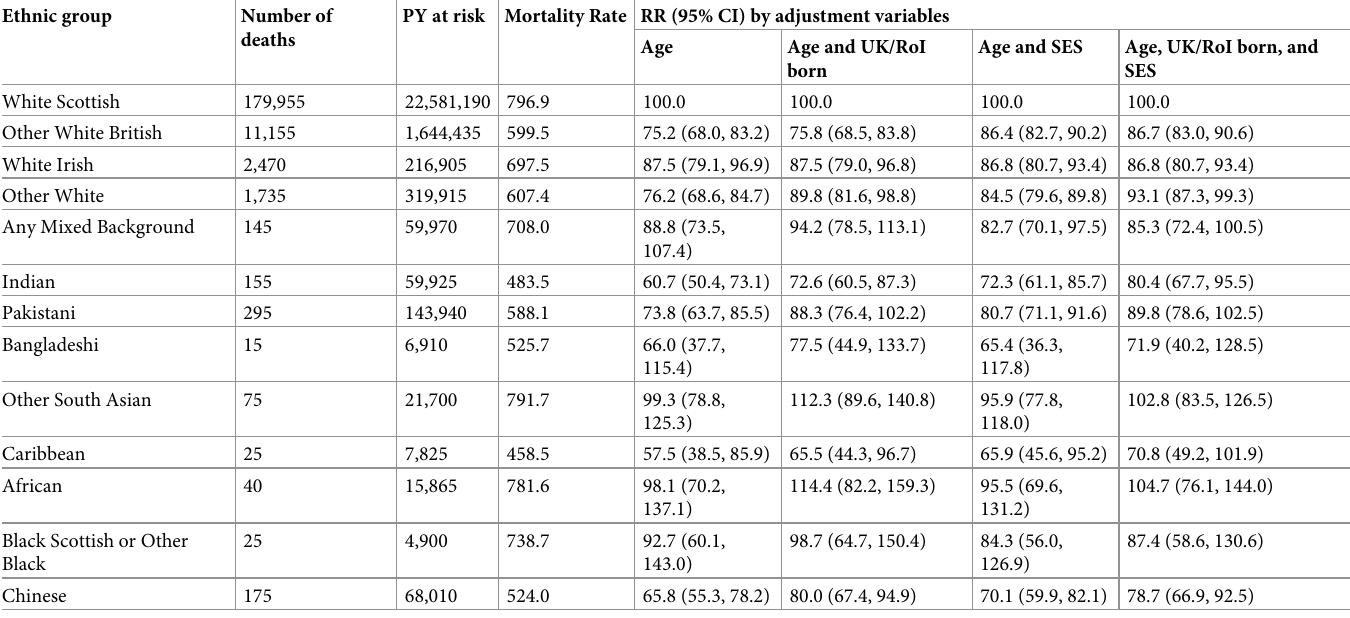
RRs are adjusted for age, UK/RoI born, and SES (Scottish Index of Multiple Deprivation, household tenure, educational attainment). CI, confidence interval; PY, person-years; RR, rate ratio; SES, socio-economic status; UK/RoI, United Kingdom/Republic of Ireland.